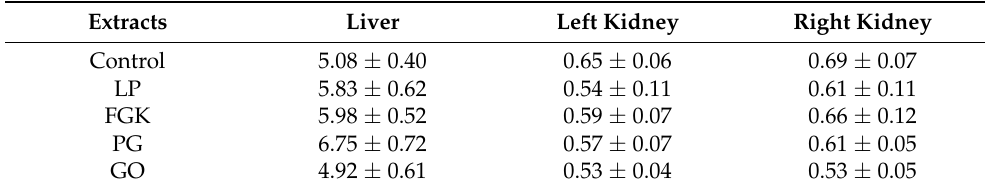
Figure 7. Effect of the oral administration of the plant aqueous extracts on the body weight variation in normal rats after four weeks. Table 2. Effect of the oral administration of the plant aqueous extracts on relative weights of livers and kidneys in normal rats.